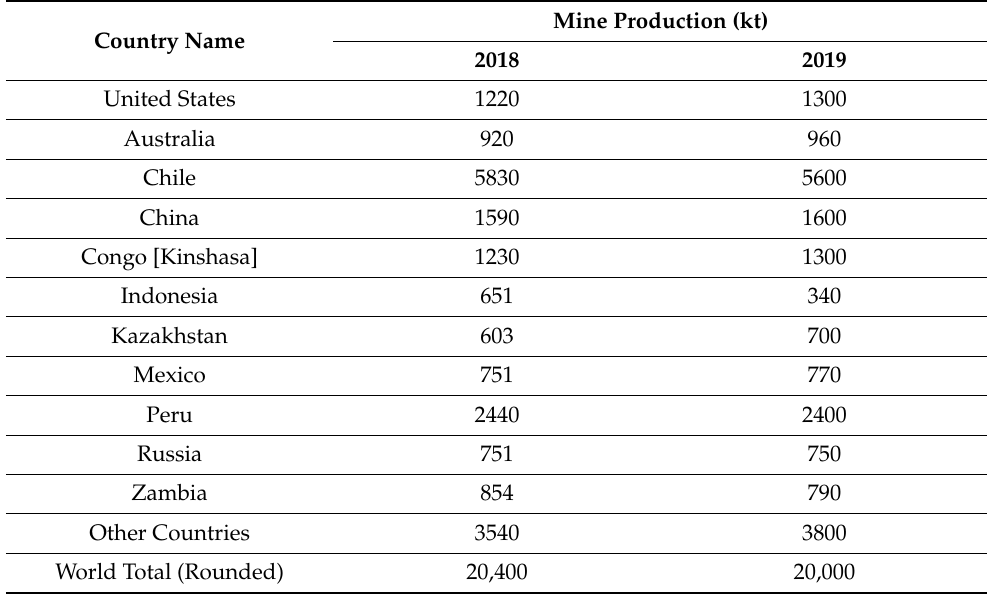
Table 1. The world mine production by various countries [32].